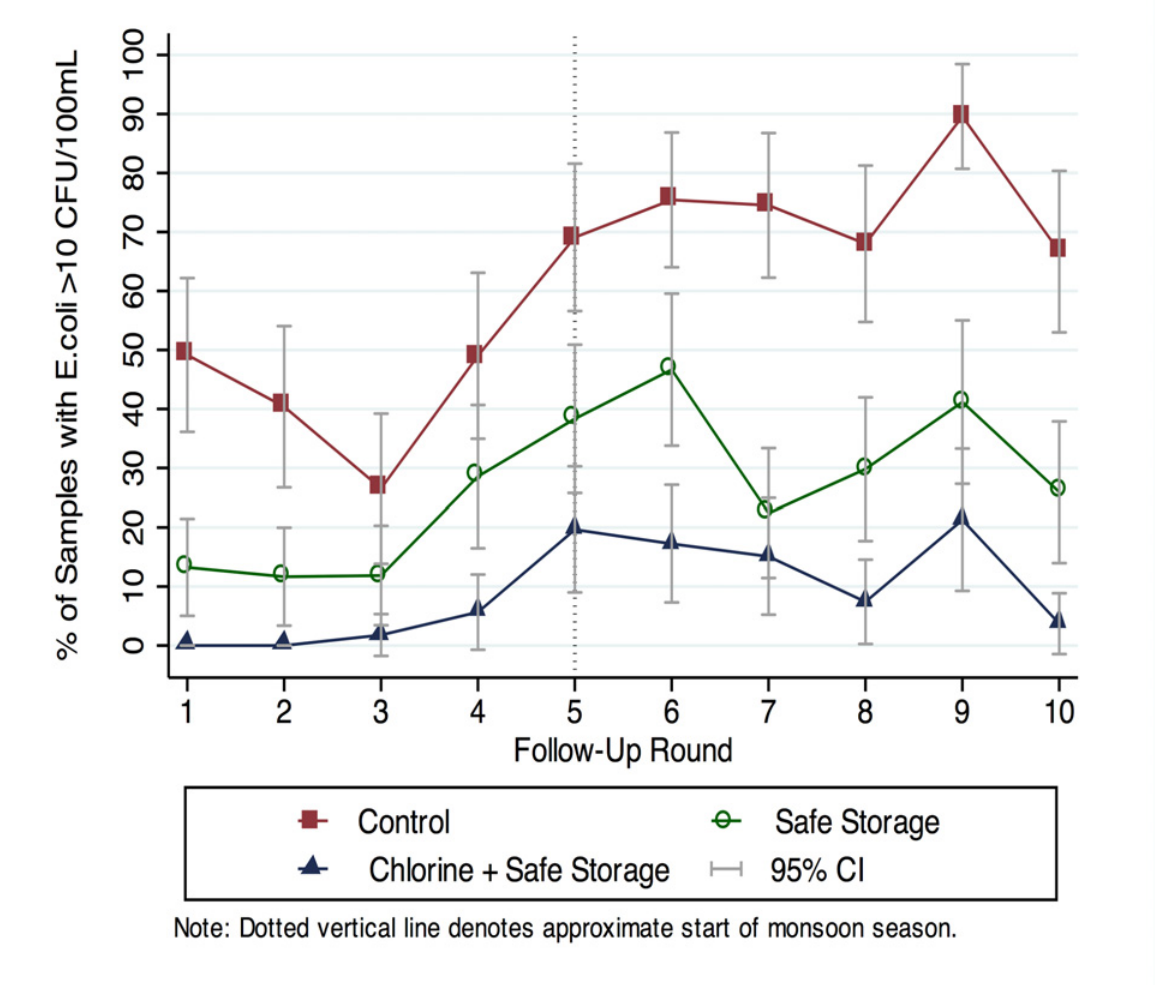
Fig 4. Temporal trend in percentage of stored water samples with E . coli > 10 CFU/100